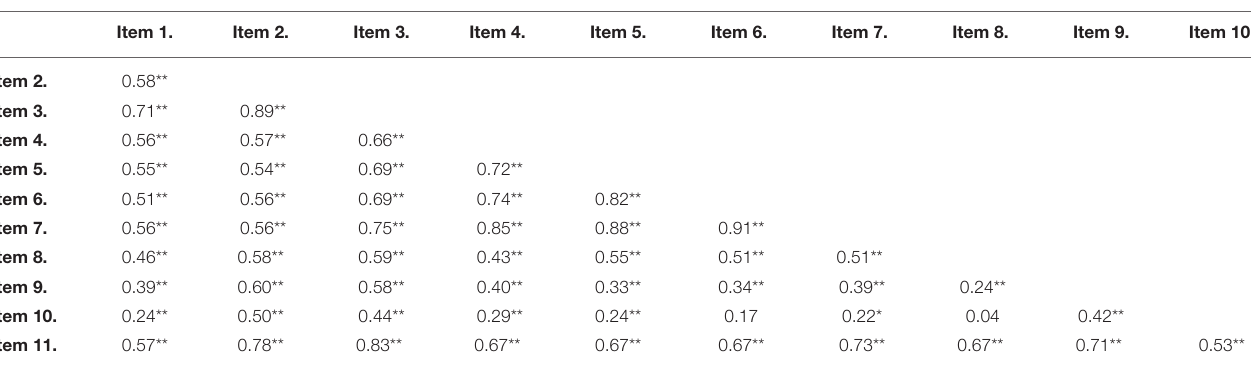
TABLE 4 | Polychoric correlations between